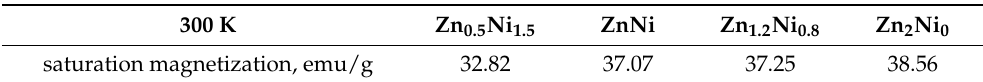
Table 1. Magnetization values at a magnetic field of 50 kOe for the samples depending on the Zn:Ni cation